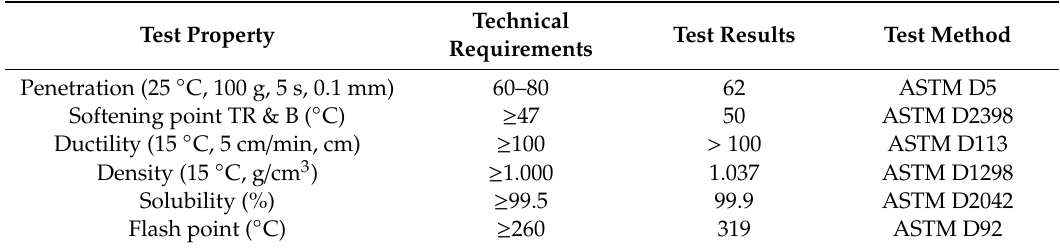
Table 1. Performance and technical requirements of A-70 base asphalt.